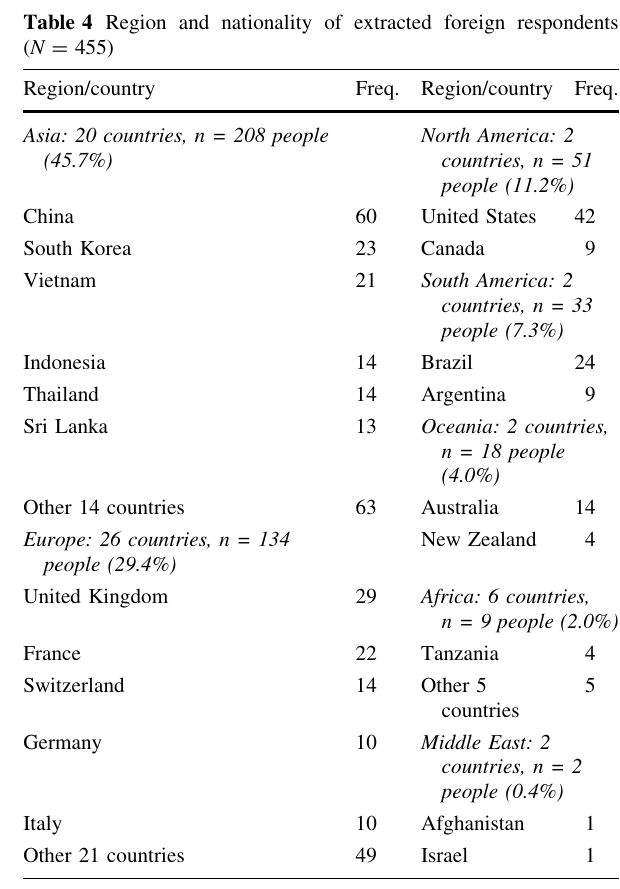
Table 4 Region and nationality of extracted foreign